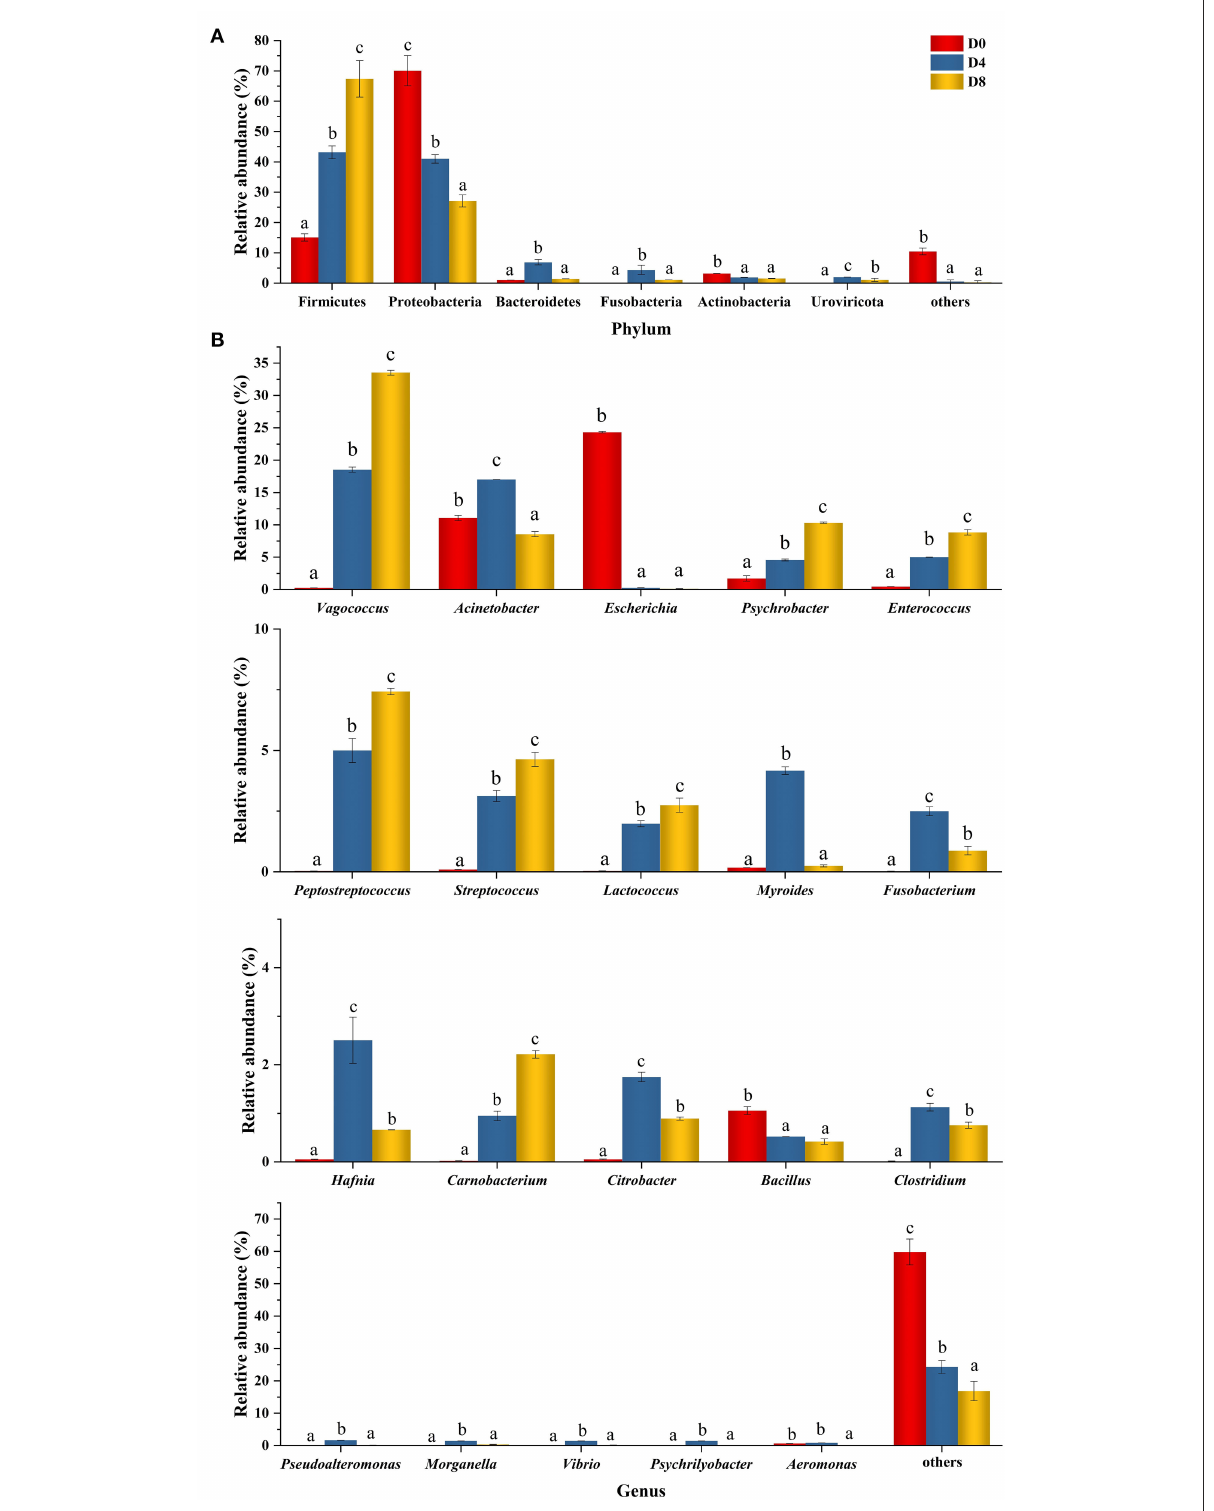
FIGURE4 Changes in the relative abundance of the microbial community at the (A) phylum and (B) genus level in Chouguiyu during the fermentation